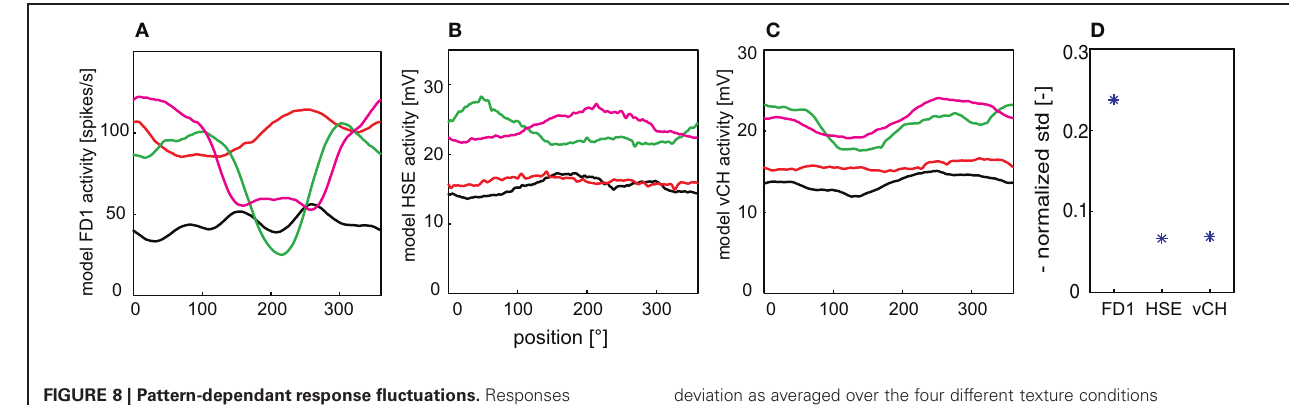
FIGURE 8 | Pattern-dependant response fluctuations. Responses of the FD1 (A) , HSE (B) , and vCH (C) model to a drum rotating at a velocity of 360 ◦ /s around the model. (D) The normalized standard